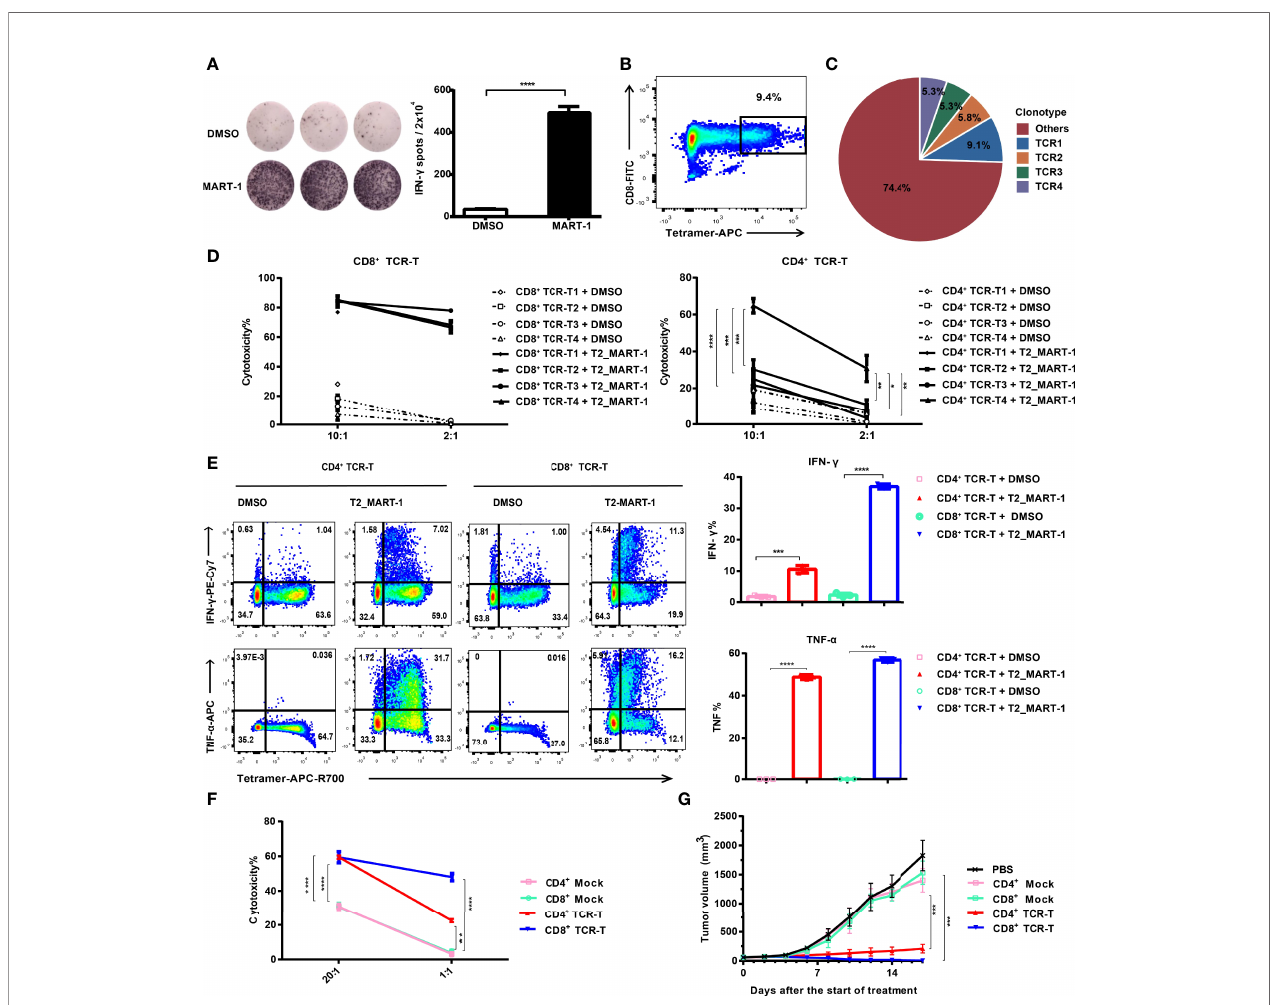
FIGURE 1 | Construction and functional validation of MART-1 27-35 -speci fi c CD4 + TCR-Ts. (A) IFN- g ELISPOT results after co-culture of CD8 + T cells with MART- 1 27-35 or DMSO-pulsed T2 cells. (B) FACS sorting of MART-1 27-35 -speci fi c T cells stained with tetramers. (C) Pie chart of TCR clonotype frequency from single-cell V (D)J sequencing. (D) Cytotoxicity of CD8 + TCR-Ts and CD4 + TCR-Ts expressing top4 TCR clonotypes to MART-1 27-35 or DMSO-pulsed T2 cells. (E) Cytokine production by CD8 + TCR-Ts and CD4 + TCR-Ts stimulated with MART-1 27-35 or DMSO-pulsed T2 cells. (F) Killing of A375 MART-1 melanoma cell line by CD4 + and CD8 + TCR-Ts. (G) Mean tumor growth curves of fi ve groups after treatment. NOG mice were implanted with A375 MART-1 subcutaneously. Mice were divided into fi ve groups after 7 days, and received different treatment through peritumoral injection at day 0 (start of treatment) and day 7: PBS (n = 5), CD4 + mock T (n = 3, 3.0×10 7 ), CD4 + TCR-T (n=5, 3.0×10 7 ), CD8 + mock T (n = 5, 3.0×10 7 ) and CD8 + TCR-T (n = 5, 3.0×10 7 ). Tumor volume was calculated every 2days. (A-F) , groups were compared with a two-sided, unpaired t-test. (G) , groups were compared with the one-way ANOVA analysis. Error bars denote the SD. *:P < 0.05; **:P < 0.01; ***:P < 0.001; ****:P <